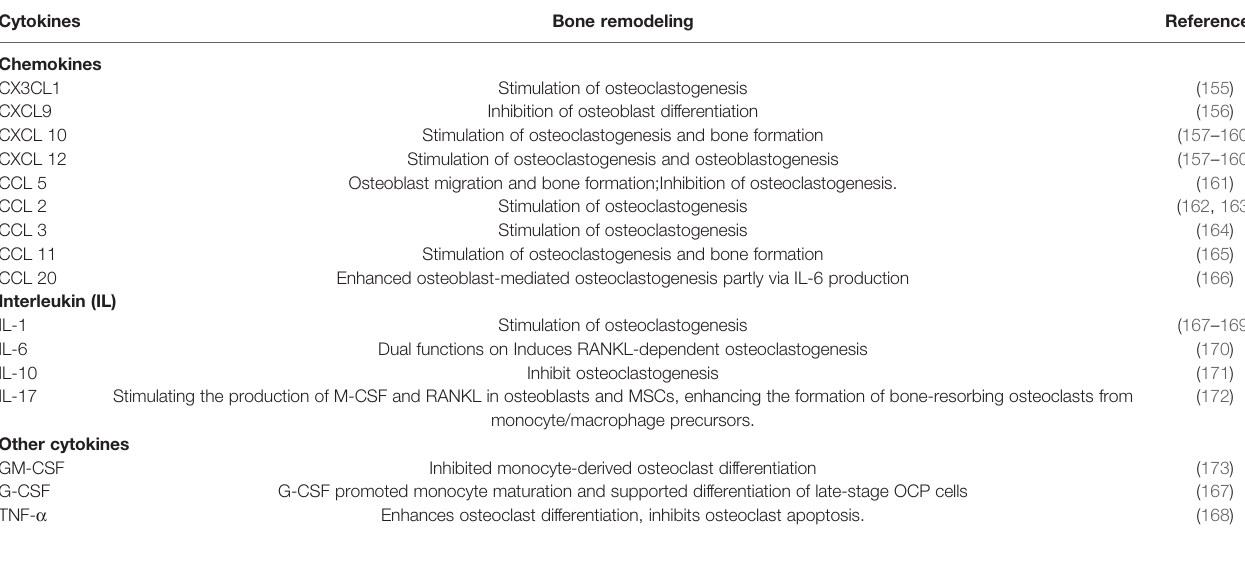
TABLE 2 | The effects of cytokines on bone